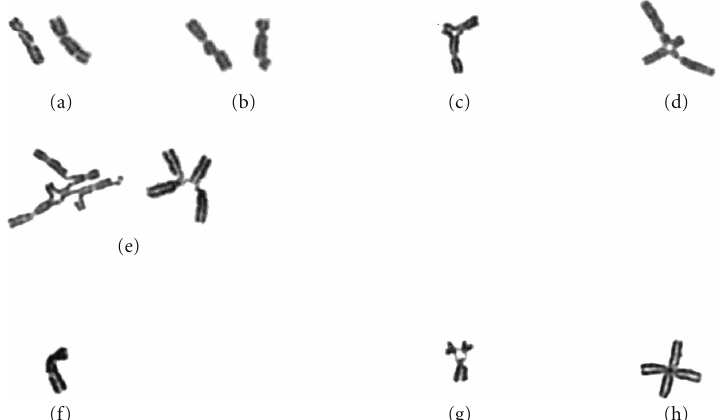
Figure 1: Examples of chromosomal aberrations typically observed in a MMC-induced chromosomal breakage assay to diagnose FA. (a) Chromatid gap (broken piece in place); (b) chromatid break (broken piece dislocated); (c) chromatid interchange figure (“triradial”); (d) chromatid interchange figure (“quadriradial”); (e) other chromatid interchange figures. In the eventual analysis, (a) and (b) are counted as one, (c) and (d) as two break events. The left figure in (e) is counted as 8 break events (5 centromeres plus 3 open breaks); the right figure is equivalent to a quadriradial as in (d) (2 break events), in which two break points remained disconnected. (f), (g), and (h), are examples of nonconvincing “aberrations” that should be ignored in the analysis. (f) A gap that is not 100% convincing and should be ignored. (g) An association of 3 acrocentric chromosomes showing “satellite association”, not to be confused with a triradial, as in (c). (h) Two overlapping chromosomes, not to be confused with a true quadriradial, as in